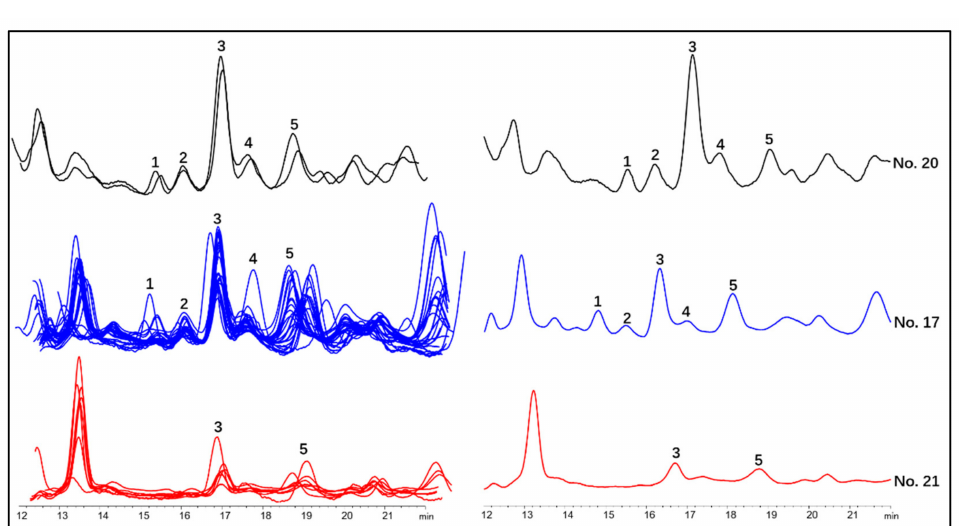
Figure 7. The chromatographic features of cultivated ginseng (red), ginseng under forest (blue), and wild ginseng (black) between the retention time 14–20 min. (Left: the overlapped graphs of all the cultivated, ginseng under forest, and wild ginseng samples; right: the chromatograms of cultivated ginseng no. 21, ginseng under forest no. 17, and wild ginseng no. 20. Characteristic peaks were tentatively identified via HPLC-IT-TOF-MS n as: 1, (B4-b)-glc-xyl; 2, (B3-b)-glc-rha; 3, ginsenoside Re